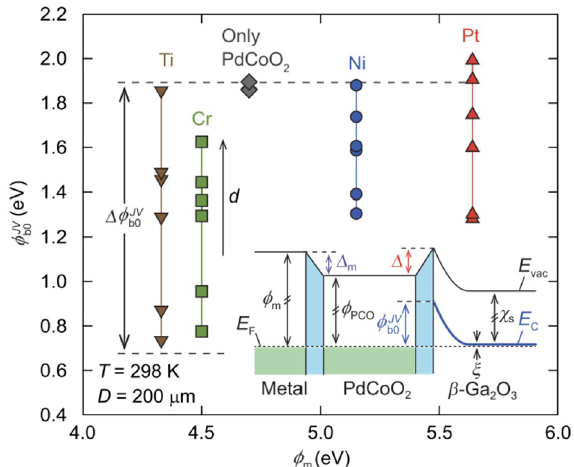
Fig. 6 Plots of barrier height versus metal work function for metal/ β -Ga O contacts with an PdCoO interlayer (IL). With 2 3 2 increasing the thickness d of PdCoO IL from 0 to 20 nm, the bar- 2 rier height was found to increase. The inset shows the possible band diagram with a PdCoO (IL). (Reprinted from ref. 97, under 2